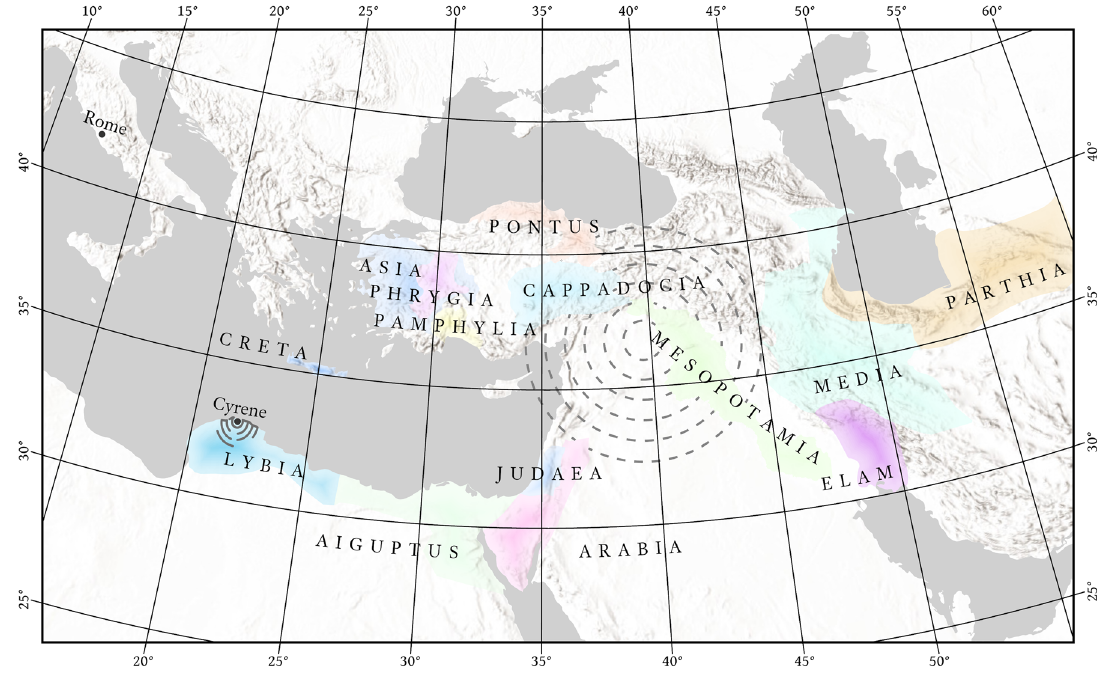
Figure 1: The geographical structure of the list of nations in Acts 2:9 –